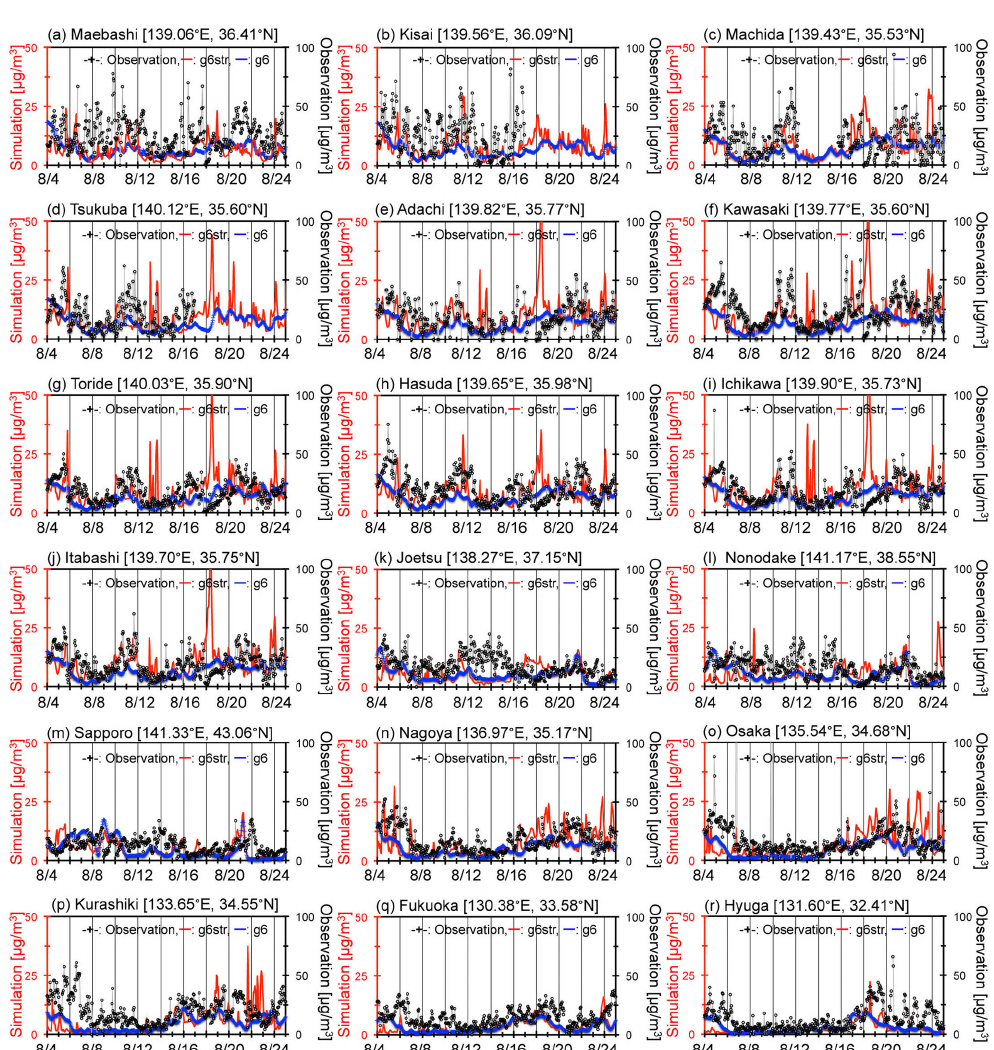
Figure 17. Temporal variations in the NICAM-g6str and NICAM-g6 simulated and observed PM 2 . 5 near the surface at 18 Japanese sites in August 2007. The left axis in red represents the simulated values, and the right axis in black represents the observed values, in units of µgm − 3